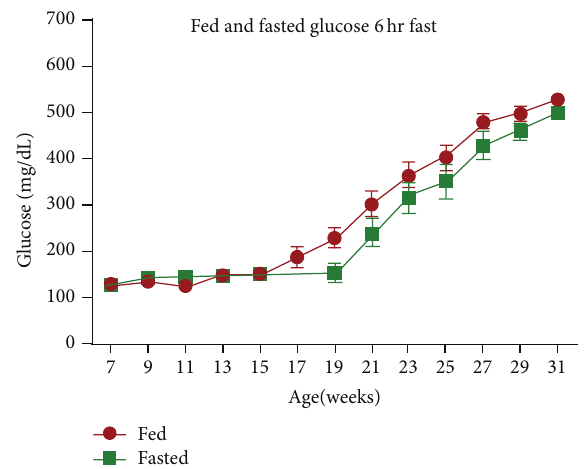
Figure 2: Glucose levels were taken biweekly in fed ( e ) (BG) or fasted ( ◼ ) plasma glucose ZDSD rats throughout the study duration of rats in ages 7 to 31 weeks (mean ± SEM, 𝑛 = 23 ).